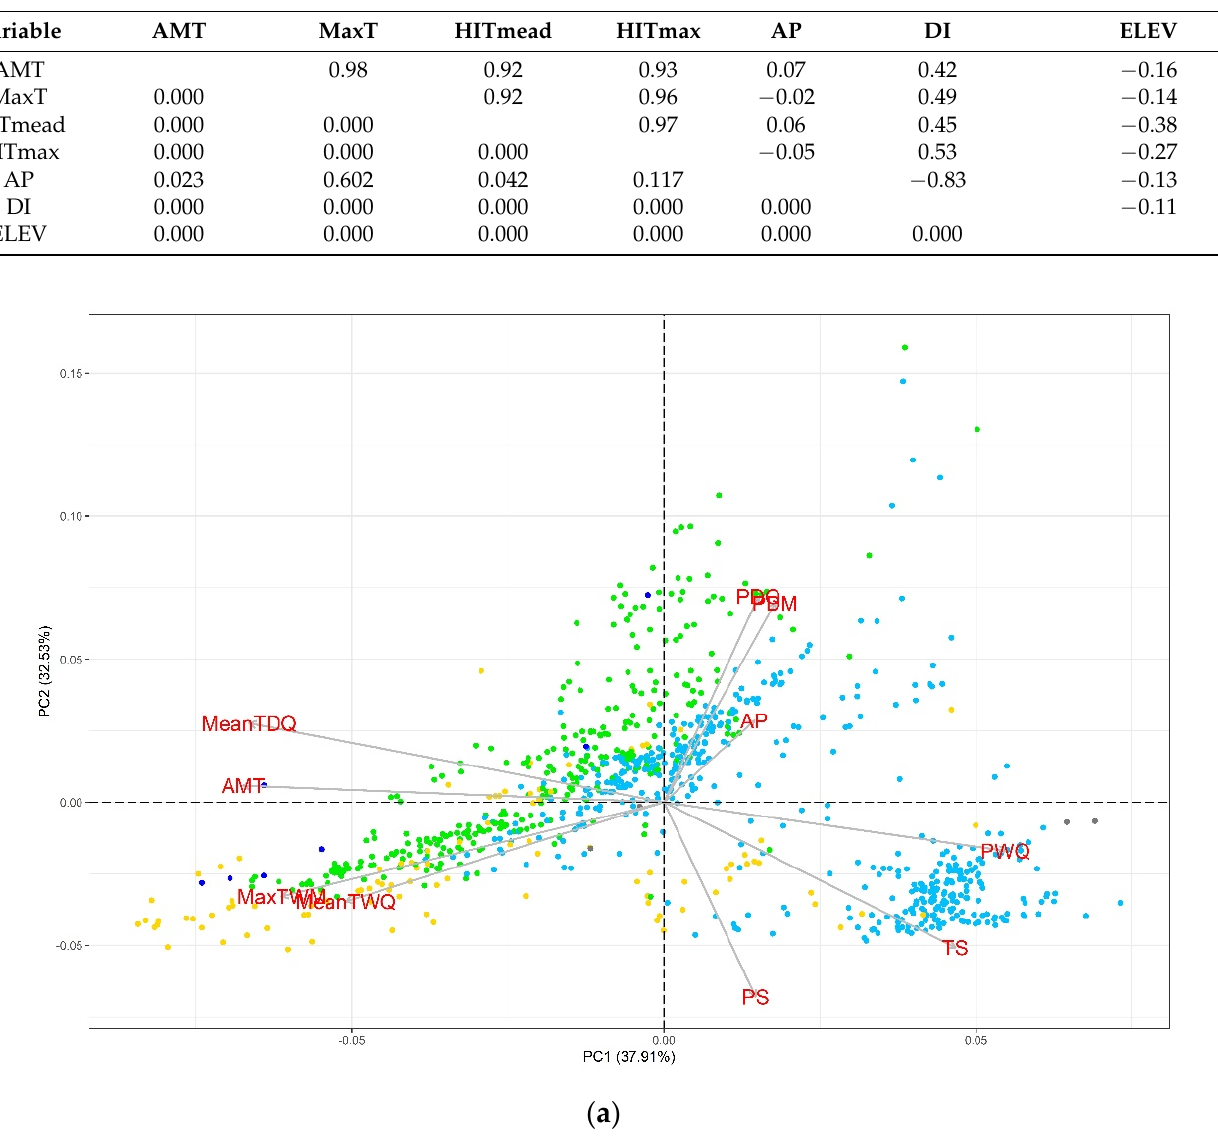
Correlation table for precipitation, temperature-related variables, calculated indices, and